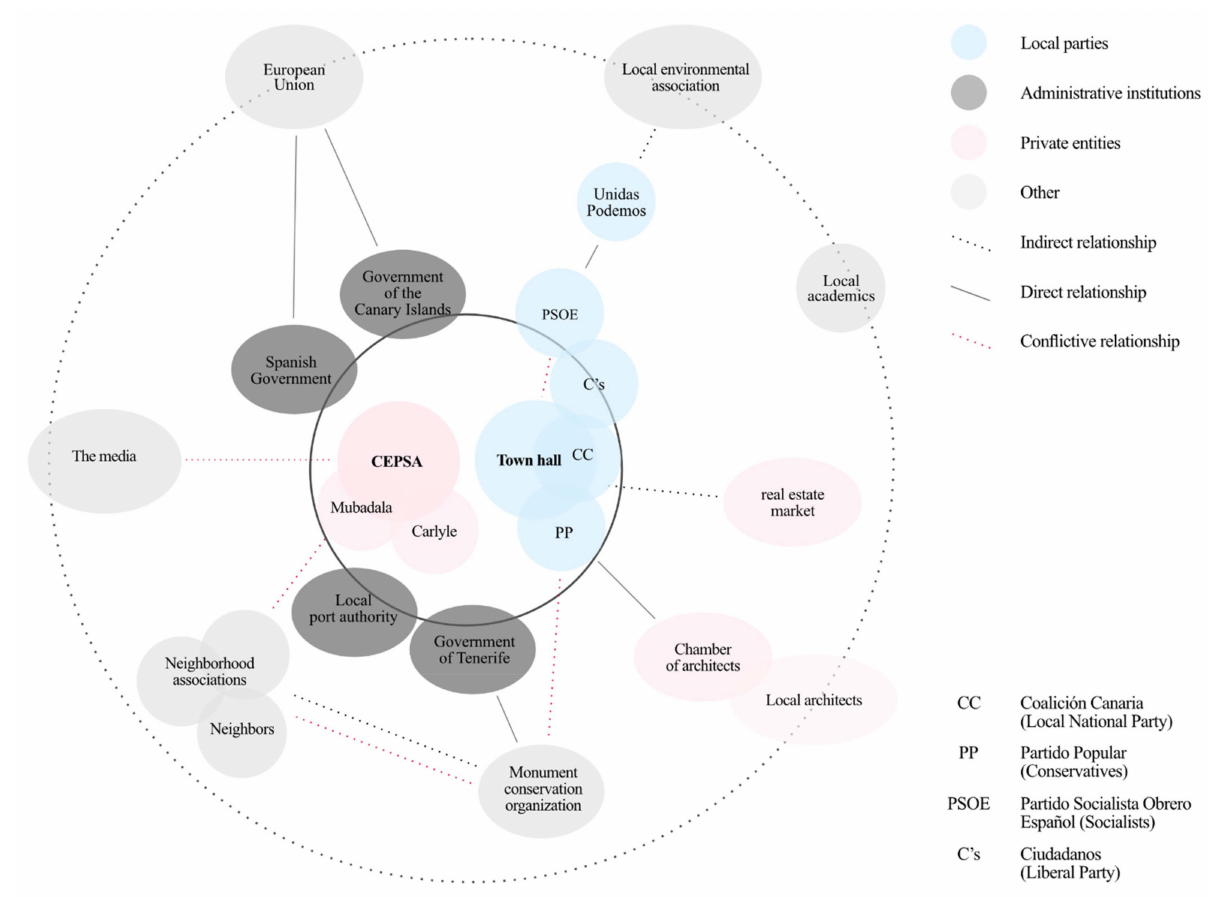
Figure 5. Primary and secondary stakeholders within the network. Own elaboration based on the